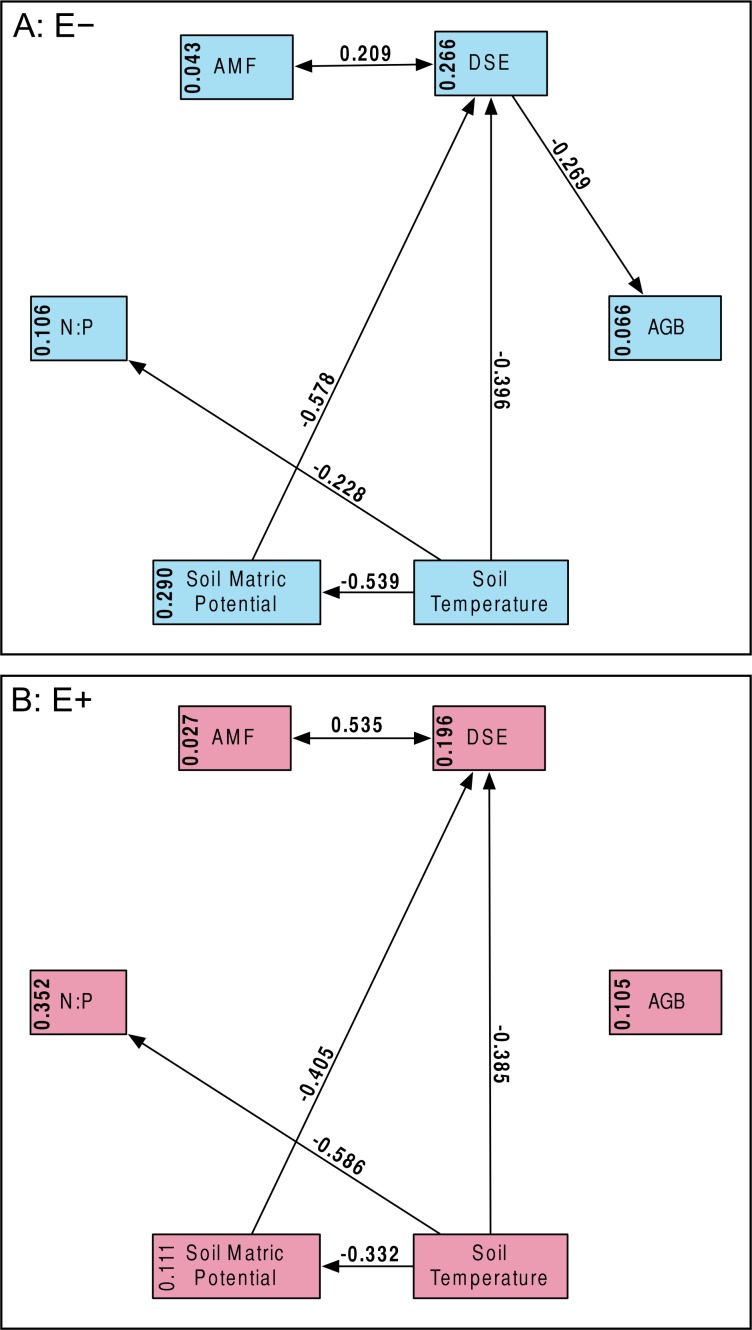
Structural equation model results.Overall SEMs, with different models for those plants without Epichloë endophytes (A: E −, blue), and those with Epichloë endophytes (B: E +, red). Model fit was good for both models (A: χ2 = 2.50, P = 0.114; CFI = 0.981; RMSEA = 0.124; n = 99|B: χ2 = 0.63, P = 0.427; CFI = 1.000; RMSEA < 0.001; n = 56). The numbers above the arrows are the standardized path coefficients. Non-significant (P > 0.05) path coefficients are not shown. Numbers in the boxes are total explained variance (R2) of each variable.